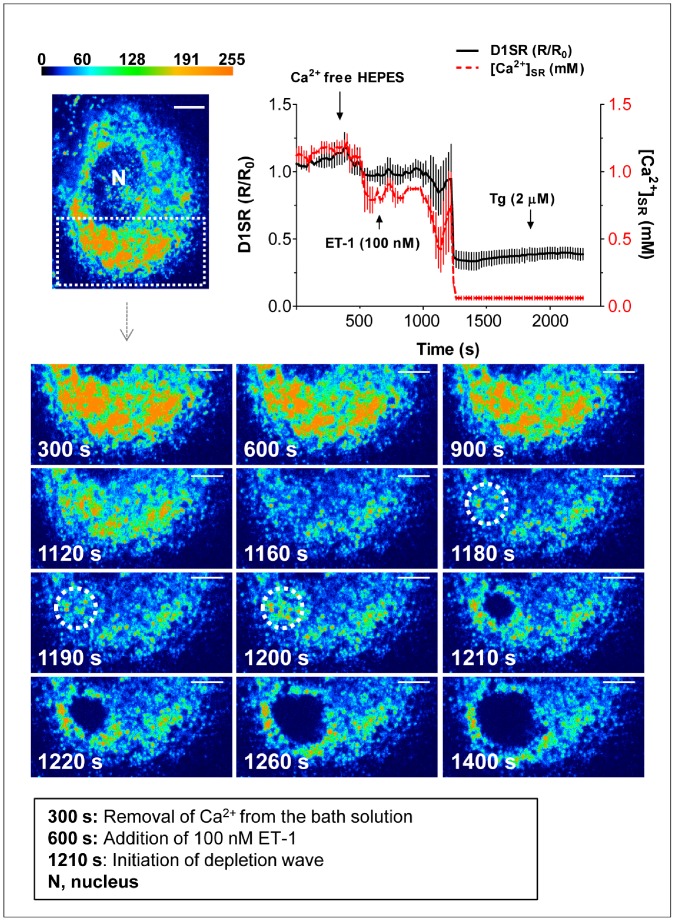
Progression of ET-1-induced regenerative Ca2+ depletion wave in the absence of extracellular Ca2+.Average trace for R/R0 values in SMCs treated with ET-1 (100 nM) and Tg (2 uM) in the absence of extracellular Ca2+. ET-1 induces a delayed bi-phasic drop in [Ca2+]SR, a small initial transient phase, followed by a large precipitous drop in [Ca2+]SR (n = 6 independent experiments, mean ± SEM, P<0.005). Representative snapshots (FRET channel) of time-lapse movie (10 s intervals) illustrates an ET-1-induced regenerative Ca2+ depletion wave over time in a SMC (scale bars, 4.3 µm). At 300 s, the bathing solution is replaced by nominal Ca2+ free HEPES. At 600 s, ET-1 (100 nM) is added, which elicits a delayed decrease in luminal Ca2+ around 1160 s post-treatment. Immediately prior to the initiation of the depletion wave, a rapid transient increase in Ca2+ is observed at the point of origin (1200 s panel, circled area), followed by a significant drop due to wave development.